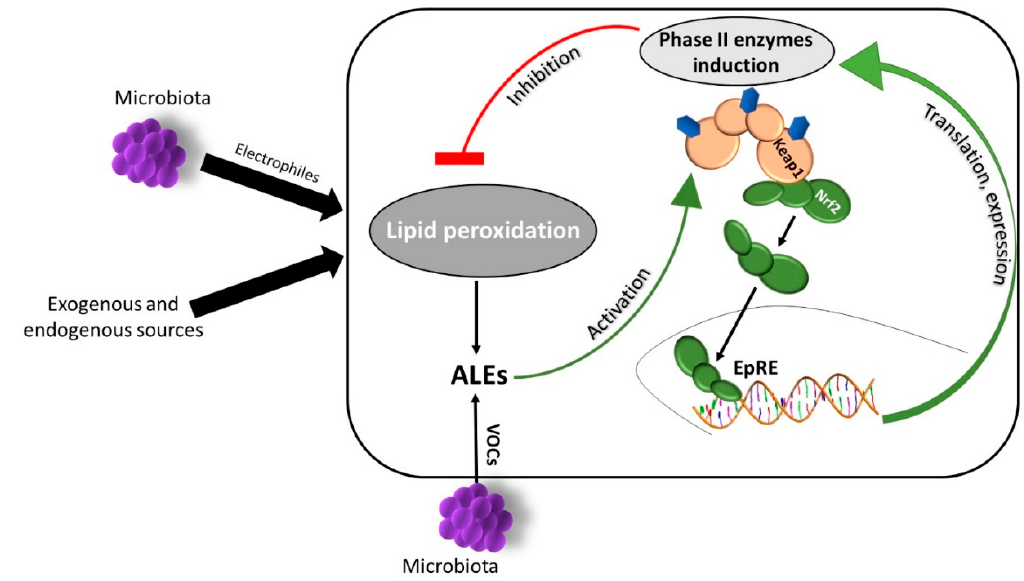
Figure 2. Cutaneous lipid peroxidation processes are modulated in a feedback based manner mediated by the Nrf2–Keap1 pathway . Physiological lipid peroxidation is naturally occurring in the skin in response to oxidative stimuli by environmental factor as well as by microbiota excretions and emanations, as well as direct interactions. Advanced lipid peroxidation end-products (ALEs are the end products of these processes but can also be contributed by resident cutaneous bacteria in the form of volatile organic compounds (VOCs). These compound can in turn activate the nuclear factor erythroid 2-related factor 2–Kelch-like ECH-associated protein 1 (Nrf2–Keap1) pathway by inducing Keap1 cysteine residues oxidation, leading to the expression of cytoprotective phase II enzymes. Then, these enzymes act in a negative feedback, inhibiting excessive lipid peroxidation, thus contributing to a healthy and balanced skin physiological redox (PR) homeostasis.